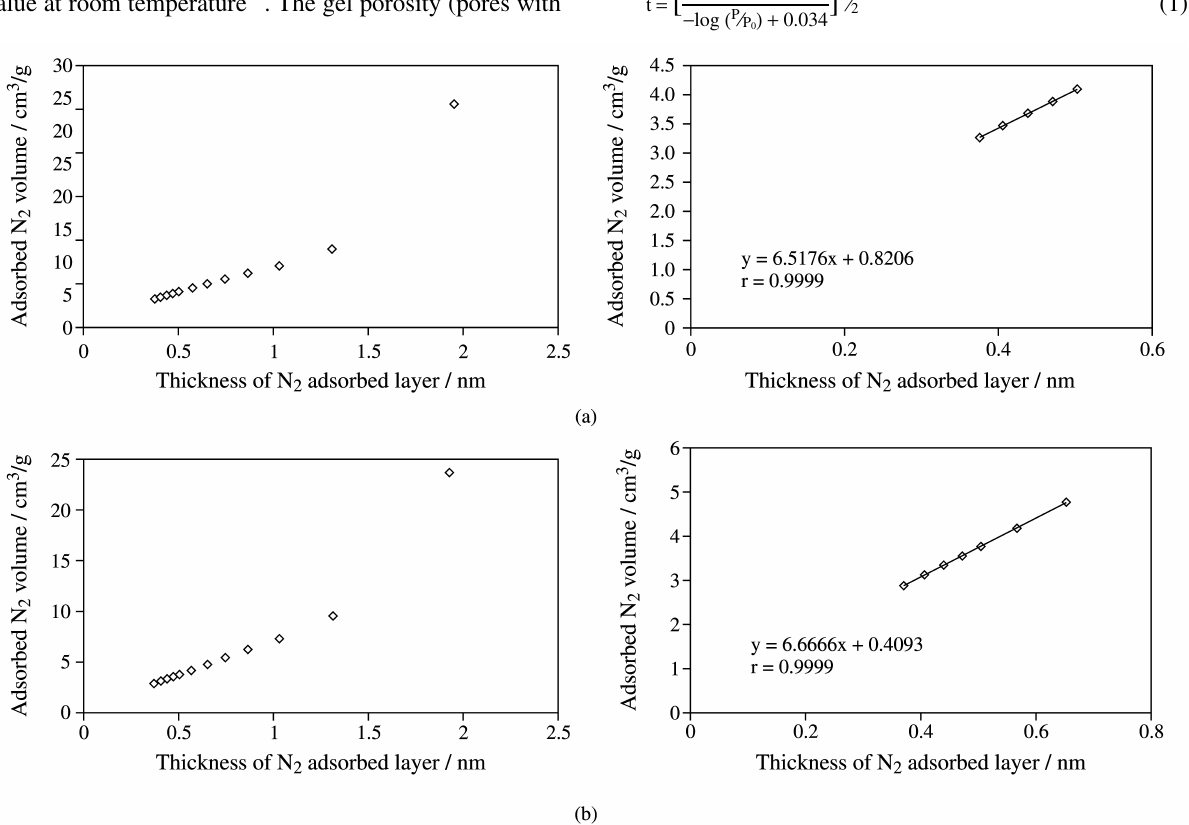
Figure 5. Adsorbed N 2 volume vs. thickness of N 2 adsorbed layer curve and the best fit line, for low pressure values, of adsorbed N 2 volume vs. thickness of N 2 adsorbed layer curve, obtained from nitrogen sorption tests for concrete with f ck of 20 MPa: (a) non heat-treated reference specimens; (b) specimens heat-treated at 600